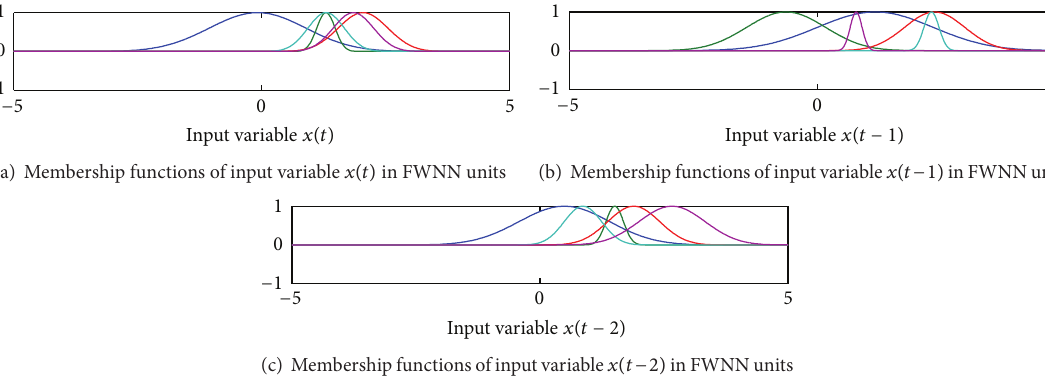
Figure 3: The membership functions of input variable 𝑥(𝑡) , 𝑥(𝑡 − 1) , and 𝑥(𝑡 − 2) in FWNN units.